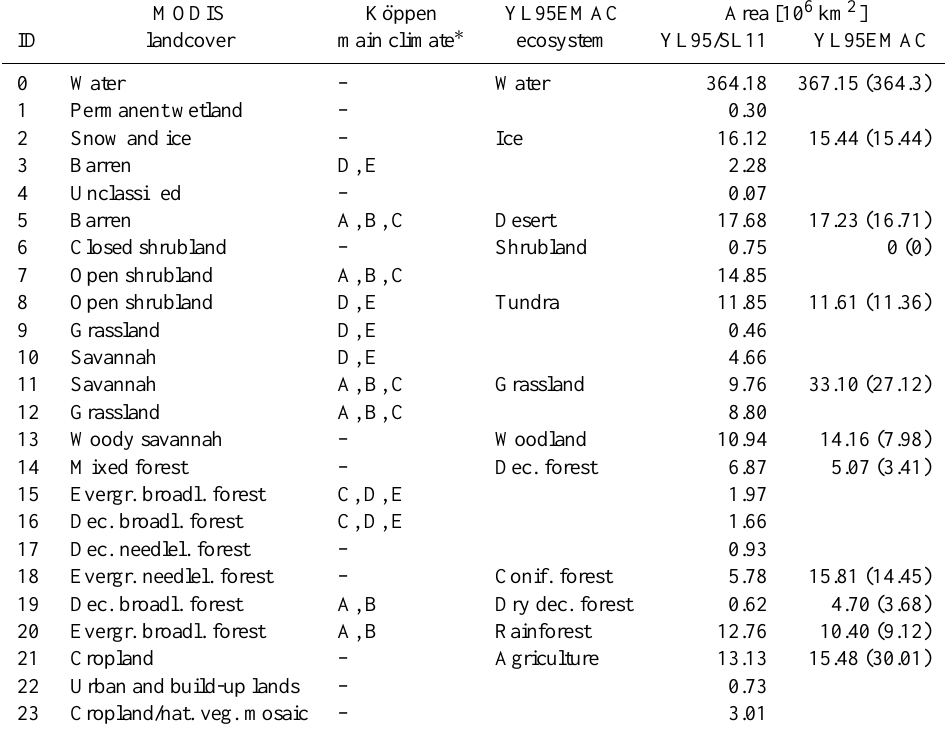
Table 1. World surface areas of the YL95EMAC ecosystems and new YL95/SL11 landcover classes in the EMAC model. For YL95- EMAC the first number is as adopted from Olson (1992) and the number in brackets gives the area reduced by (1 – cultivation index) for non-agricultural areas and the cultivated area for agriculture with the cultivation index after Bouwman et al.